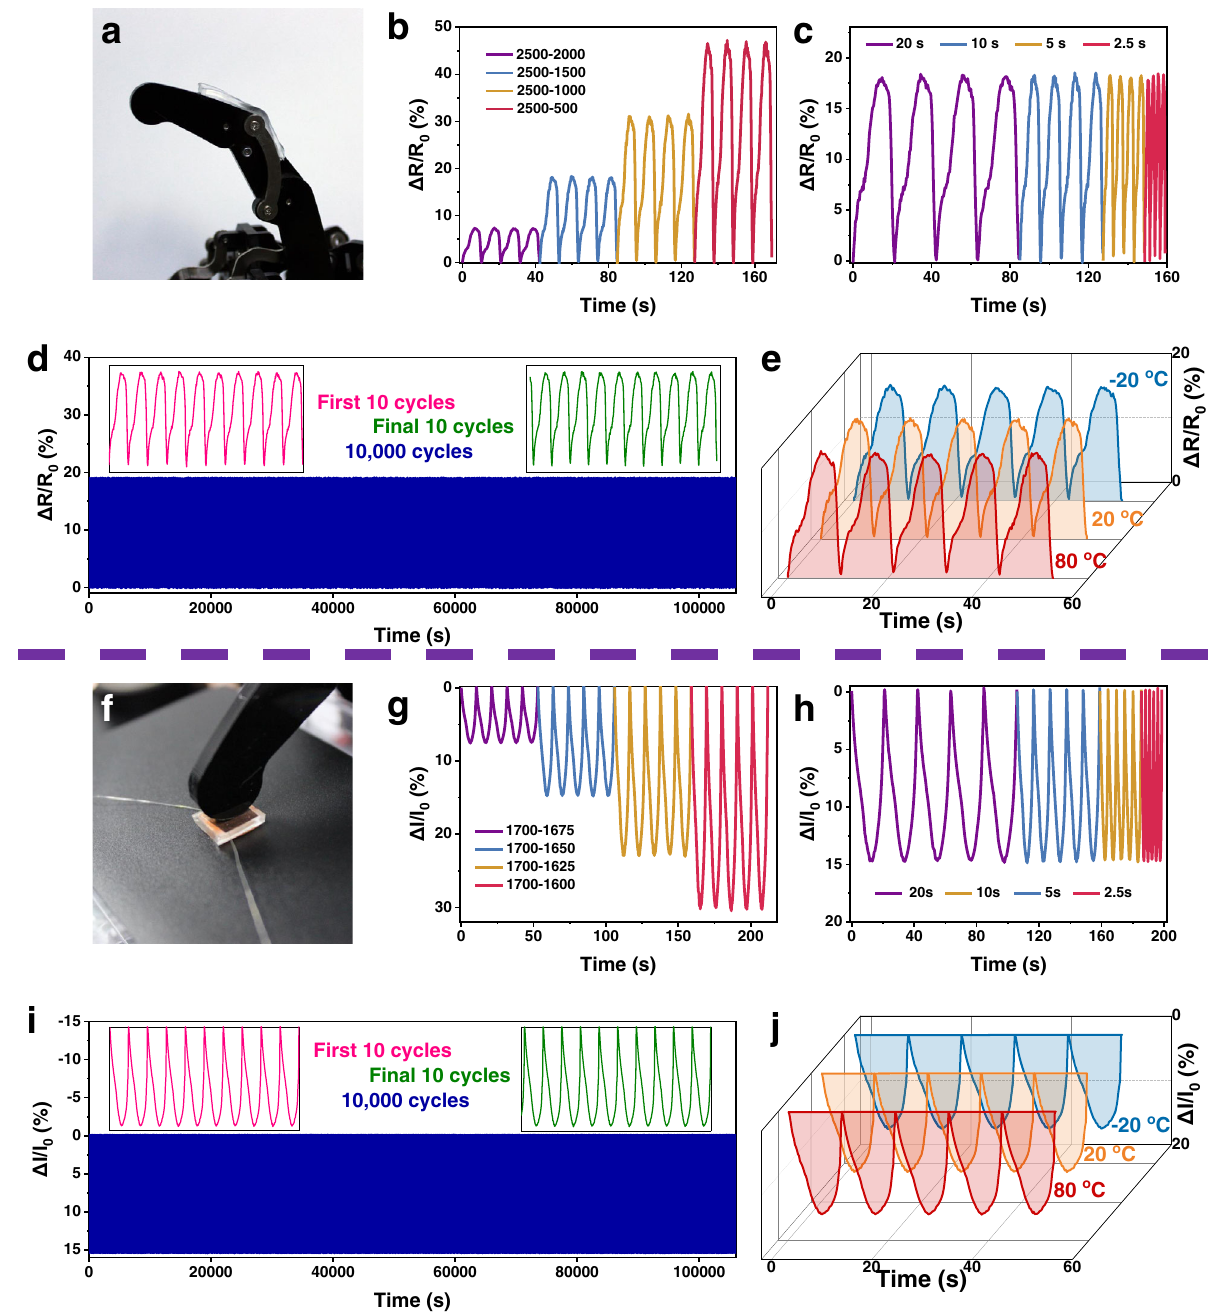
Fig. 8 | Tests with robotic fi nger. a A gel was attached on the robotic fi nger to monitor its bending. b Relative resistance changes under different bending levels. c Relative resistance change at different bending speeds (bending level: 2500- 1500). d Relative resistance changes during 10,000 consecutive fi nger bending withthebendinglevelis2500-1500.Theinsetsarethe fi rst10cyclesandthe fi nal10 cycles. e Consecutive fi nger bending atvarious temperatures. Bendinglevel:2500-